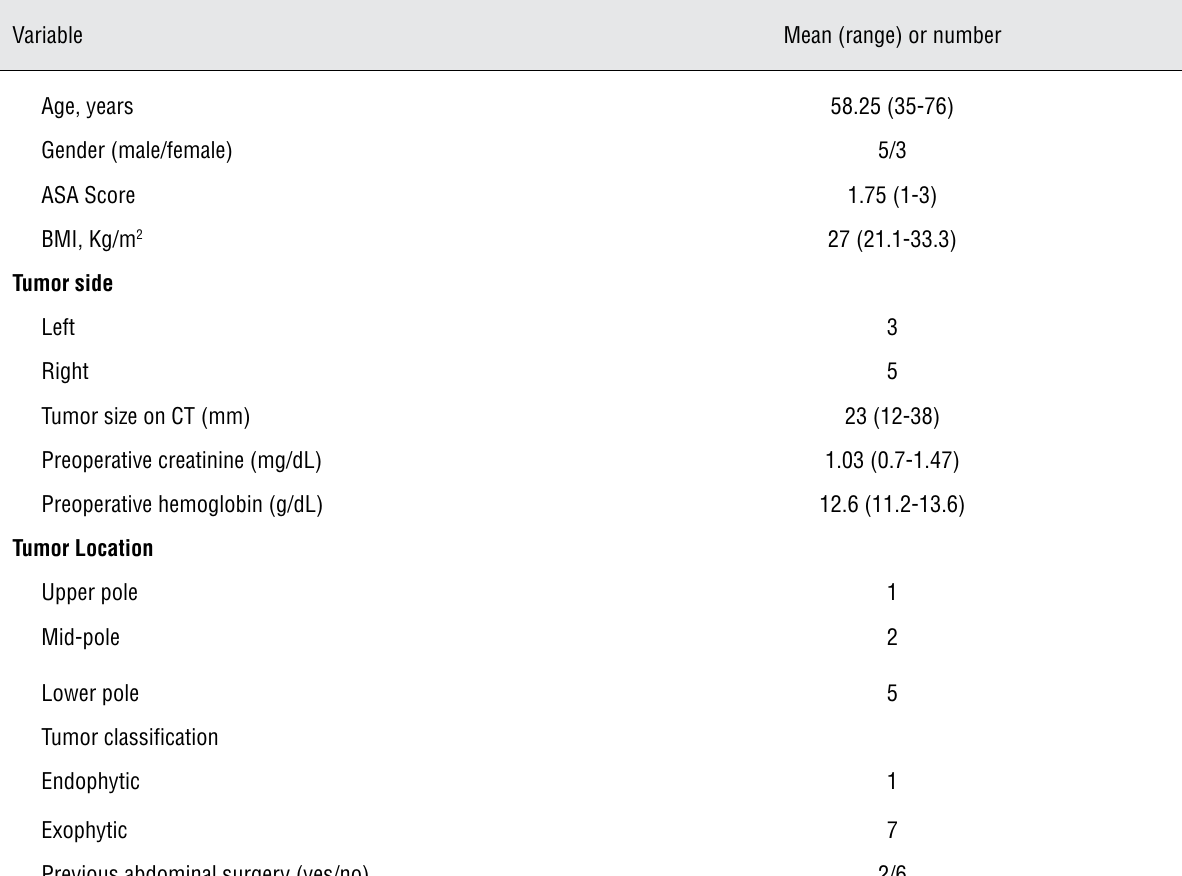
Table 1 - Patient